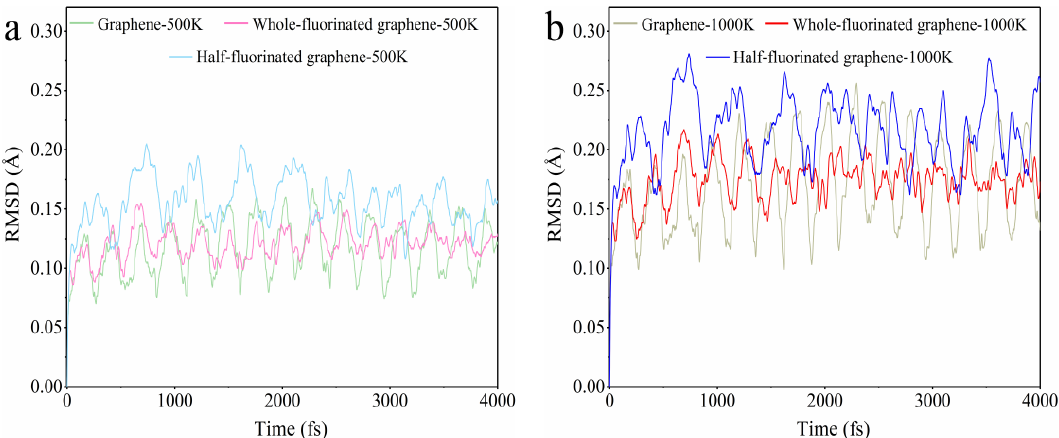
Figure 5. RMSD of AIMD trajectories for graphene, whole-fluorinated graphene and half-fluorinated graphene at 500 K and 1000 K compared with the ground state (0 fs). ( a ) RMSD of AIMD trajectories at 500 K. ( b ) RMSD of AIMD trajectories at 1000 K.